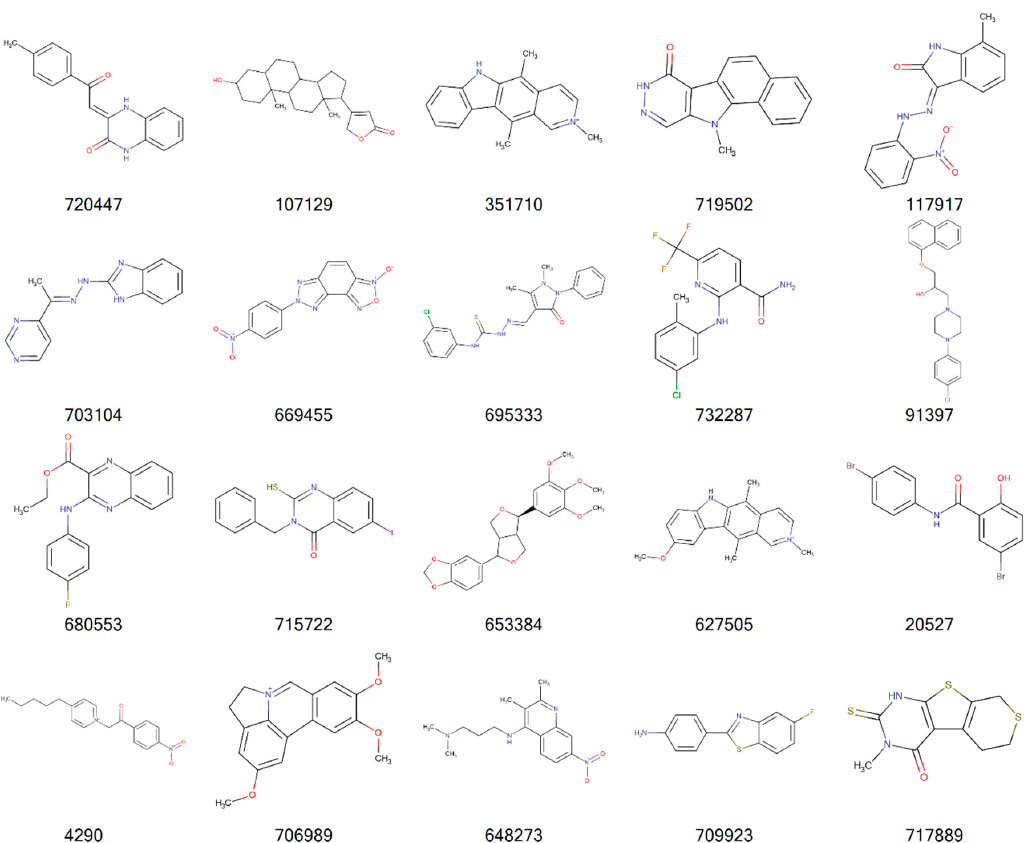
Figure 4. 2D structures of top 20 drug-like ligands for lung cancer. Listed are NSC-720447, NSC-107129, NSC-351710, NSC-719502, NSC-117917, NSC-703104, NSC-669455, NSC-695333, NSC-732287, NSC-91397, NSC-680553, NSC-715722, NSC-653384, NSC-627505, NSC-20527, NSC-4290, NSC-706989, NSC-648273, NSC-709923, and NSC-717889.